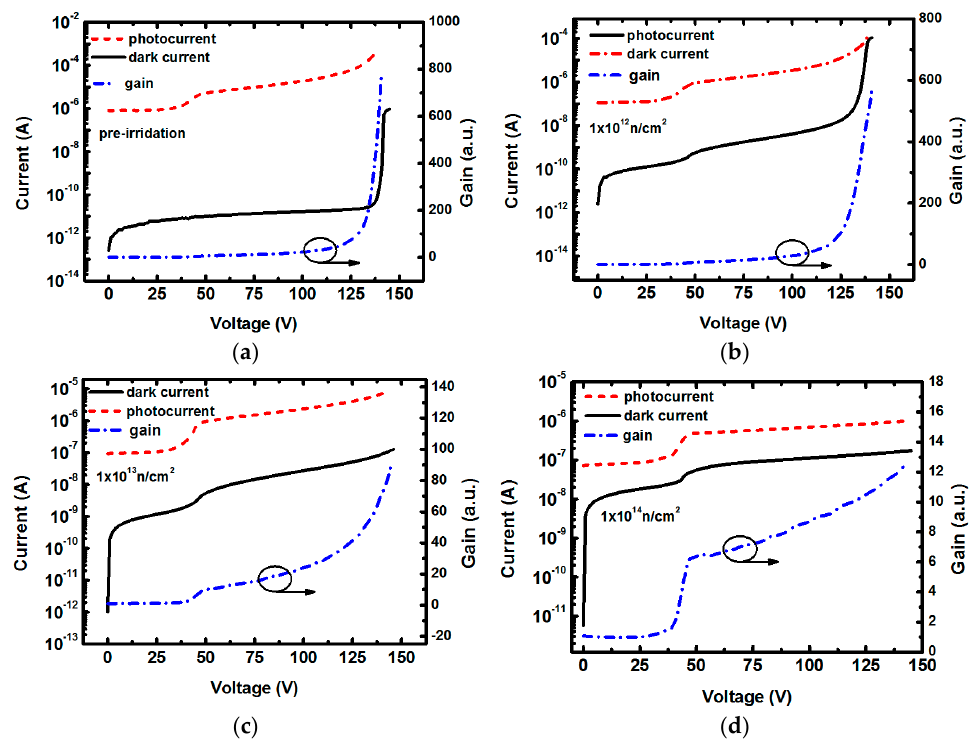
Figure 3. Reverse I-V characteristic of the Si-based APDs in dark and under illumination with incident light wavelength of 700 nm. The right-hand axis indicates the gain. ( a ) pre-irradiation; ( b ), ( c ), ( d ) under neutron fluences of 1.0 × 10 12 cm − 2 , 1.0 × 10 13 cm − 2 , 1.0 × 10 14 cm − 2 , respectively. Similar to Si-based APDs, the reverse I-V curves of InP-based APDs in dark and un- value. Illumination light is controlled to the monochrome wavelength of ~1550 nm, lo-